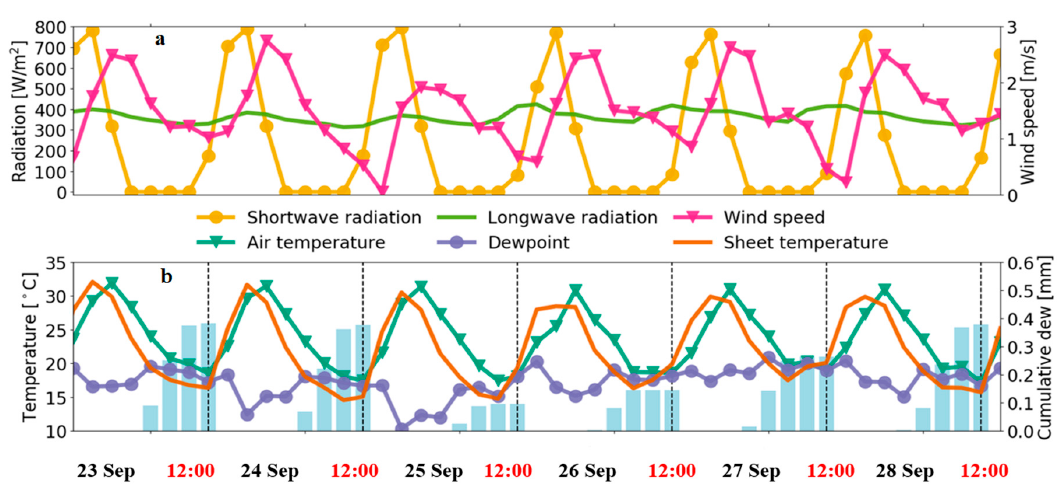
Figure A1. An example model simulation for dew formation from 23–28 September 2001 at Irbid, Jordan. ( a ) the short-wave and long-wave radiation (left y-axis) and wind speed (right y-axis) whereas ( b ) the cumulative dew formation on the condenser (bars linked to the y-axis right axis) and the ambient temperature, dew point, and condenser sheet temperature (left y-axis).